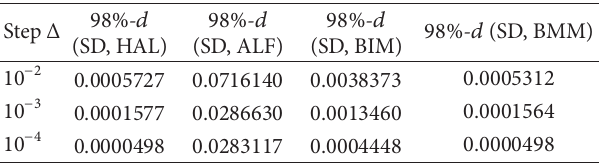
Table 3: The L 2 -distance between all the considered numerical schemes applied to SDE (2) with parameter set (𝑥 0 ,𝑘 1 , 𝑘 2 ,𝑘 3 ,𝑞,𝑇) = (1/16,1/16, 1, 0.4, 3/4, 1)